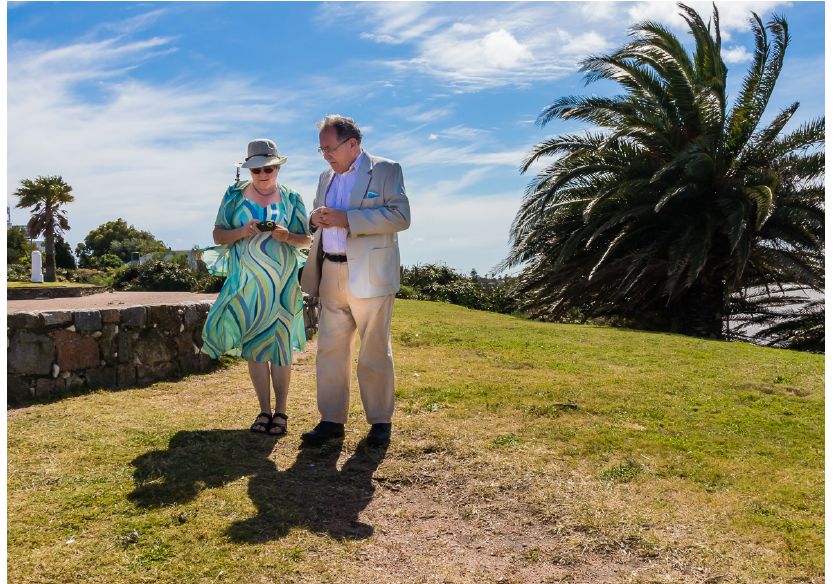
Figure 4. Outside Montevideo, but again properly dressed: Bob Sim with his wife Edith Sim—this photo nicely depicts the harmony between them.